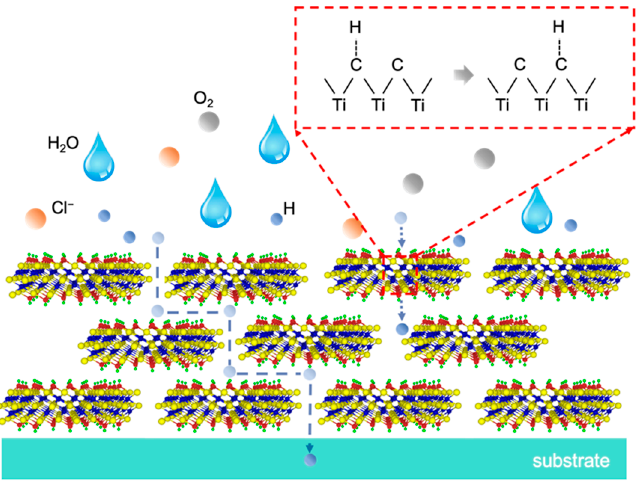
Figure 7. Schematic presentation of hydrogen permeation and corrosion processes.